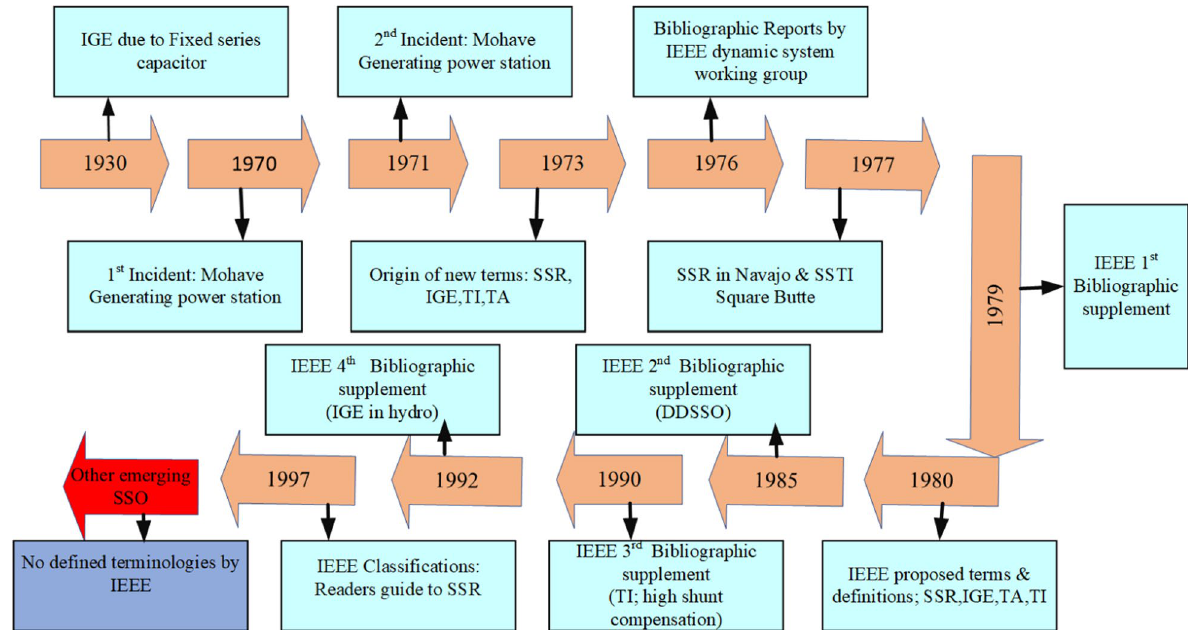
Fig. 1 Summary of evolution for traditional SSO